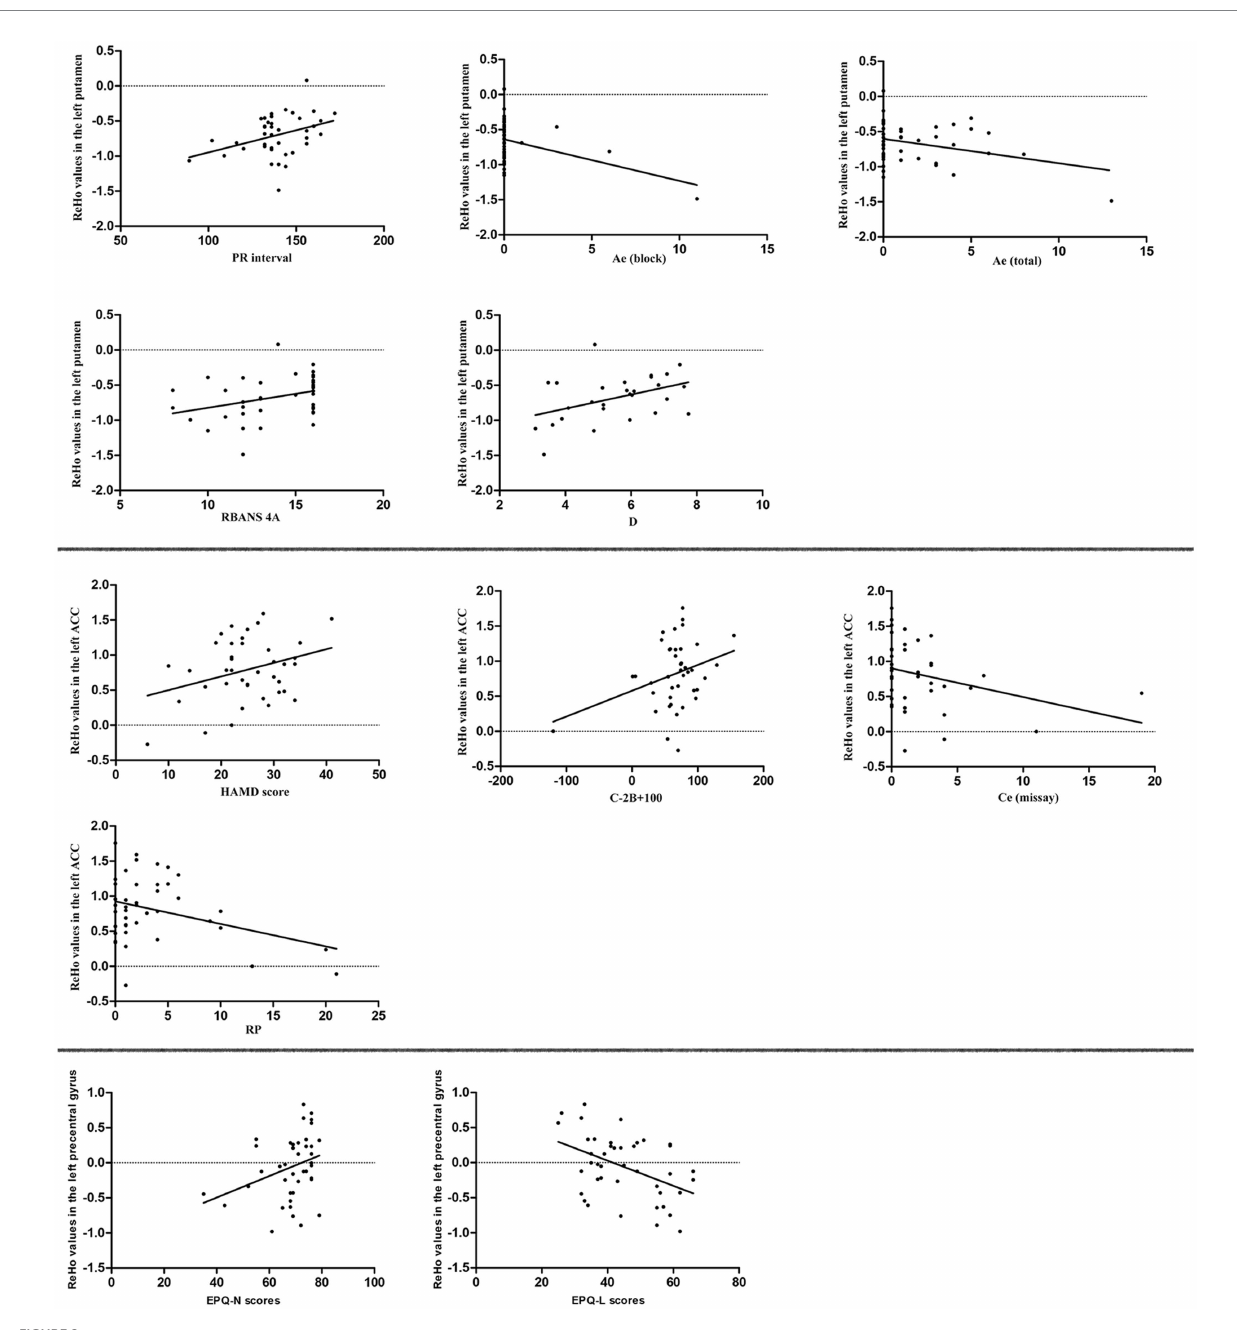
FIGURE 2 Pearson/Spearman correlation analyses showed that correlations between (1) the ReHo values in the left putamen and PR interval (r = 0.365, p = 0.021, df = 39); (2) the ReHo values in the left putamen and Ae (block; r = − 0.397, p = 0.010, df = 40); (3) the ReHo values in the left putamen and Ae (total; r = − 0.327, p = 0.037, df = 40); (4) the ReHo values in the left putamen and RBANS 4A (r = 0.334, p = 0.035, df = 39); (5) ReHo values in the left putamen and D (r = 0.428, p = 0.023, df = 27); (6) the ReHo values in the left ACC and HAMD score (r = 0.316, p = 0.047, df = 39); (7) the ReHo values in the left ACC and C − 2B + 100 (r = 0.326, p = 0.037, df = 40); (8) the ReHo values in the left ACC and Ce (missay; r = − 0.315, p = 0.045, df = 40); (9) the ReHo values in the left ACC and RP (r = − 0.346, p = 0.025, df = 41); (10) the ReHo values in the left precentral gyrus and EPQ-N score (r = 0.318, p = 0.040, df = 41); and (11) the ReHo values in the left precentral gyrus and EPQ-L score (r = − 0.446, p = 0.003, df = 41). ReHo, regional homogeneity; ACC, anterior cingulate cortex; HAMD, Hamilton Depression Rating Scale; EPQ, Eysenck Personality